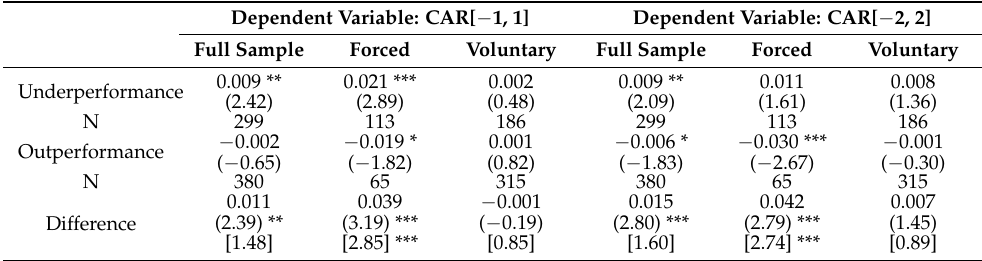
Table 7. Alternative benchmark for underperformance and outperformance classifications.